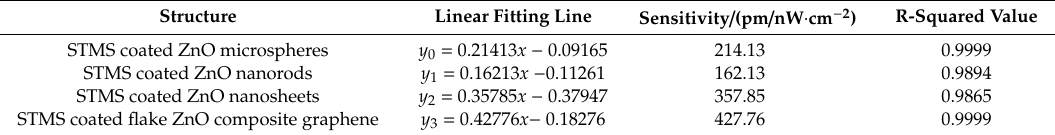
Figure 4. The wavelength shift versus ultraviolet radiation luminance for sensors.